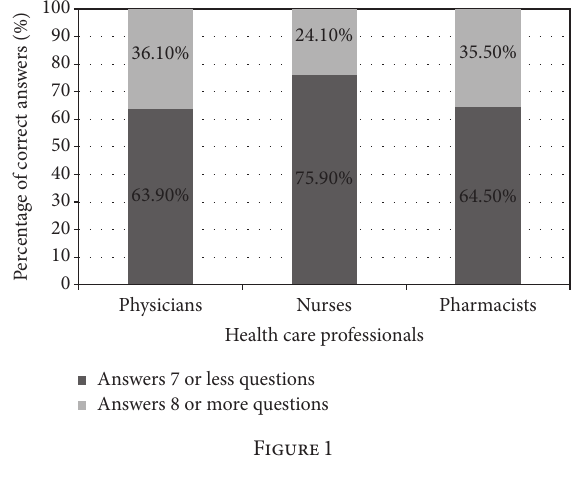
Table 1: Demographic details of